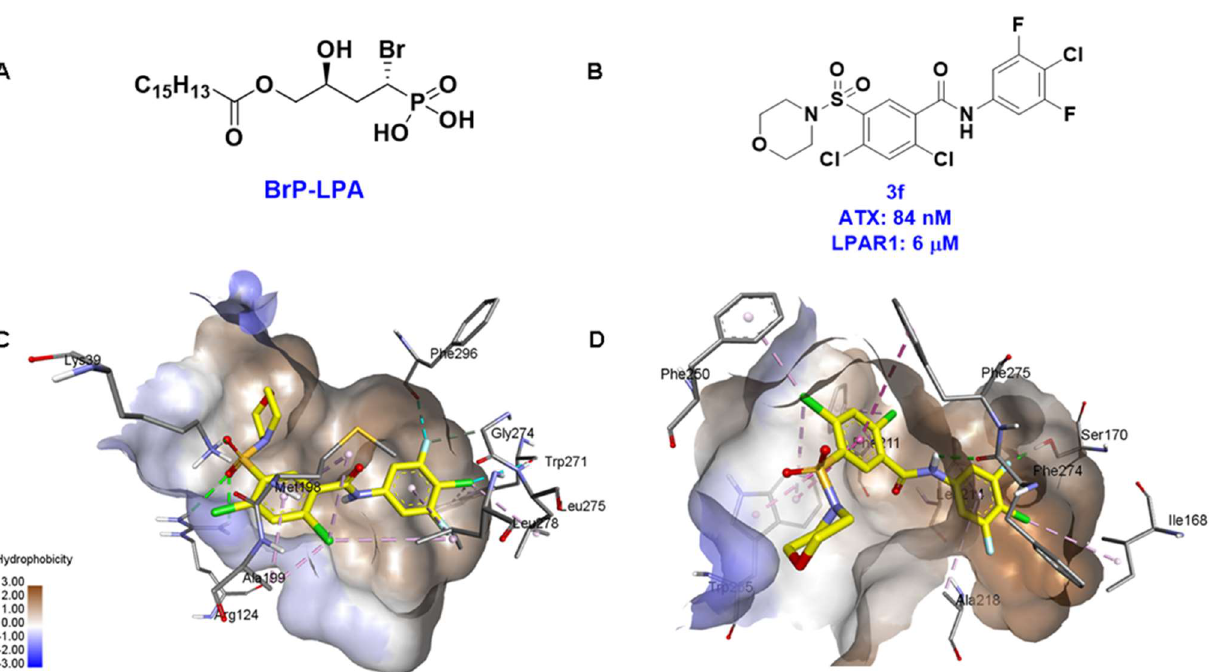
Figure 3. ATX inhibitors with LPAR inhibitory efficacy. ( A ). ATX-LPAR pan antagonist BrP-LPA. ( B ). ATX/LPAR1 dual inhibitor 3f . ( C ). Mode of binding of 3f in LPAR1 binding site (PDB: 4Z35 ). ( D ). Binding mode of 3f in ATX hydrophobic pocket (PDB: 5MHP ).